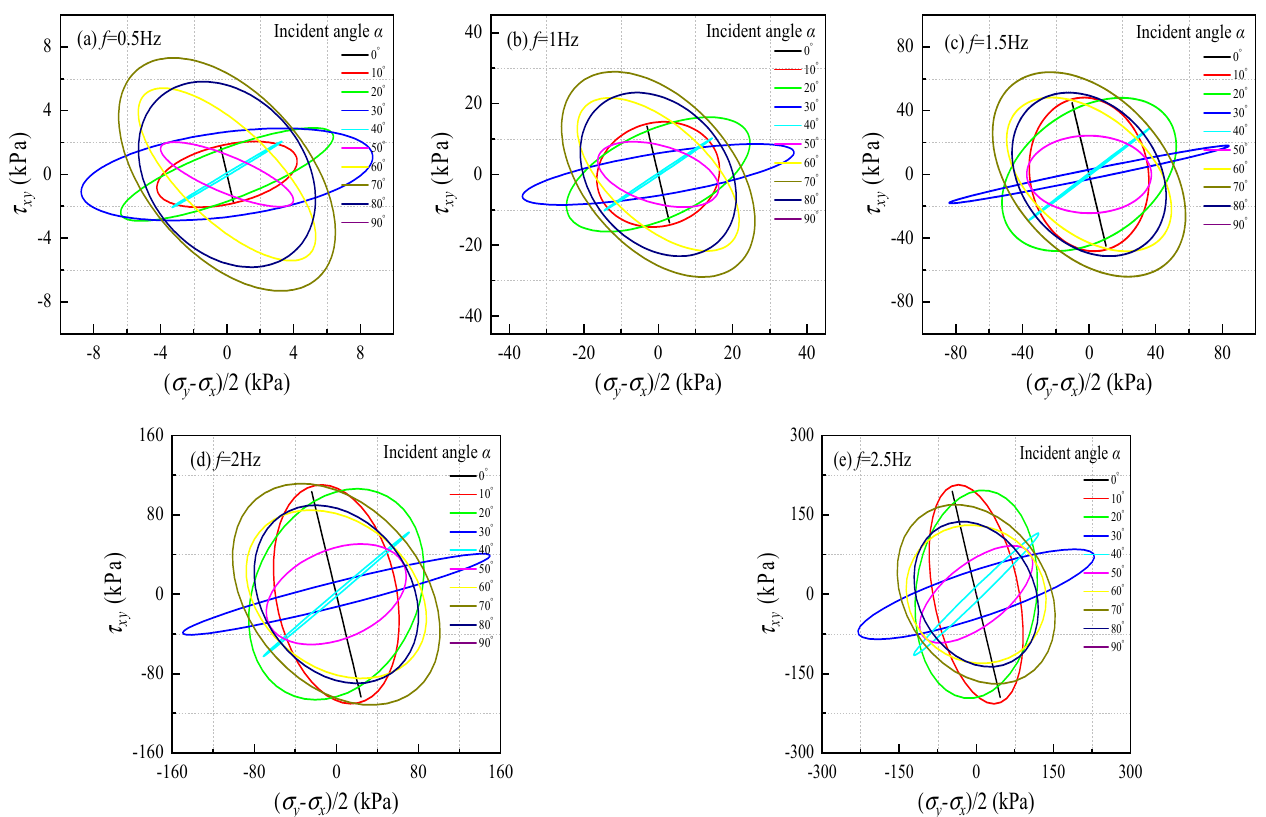
Figure 8. Variation of elliptical stress path with the incidence angle for various frequencies.